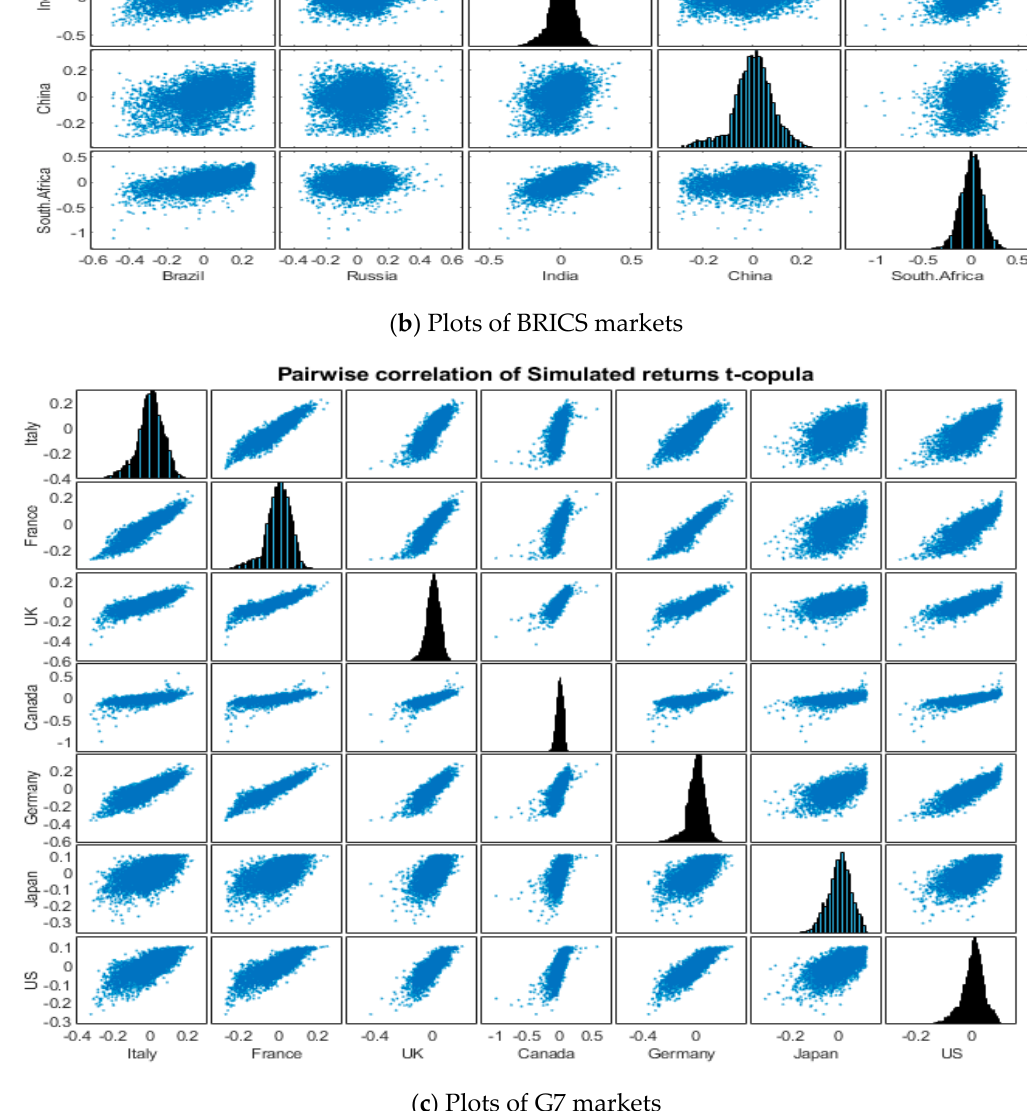
Figure 4. Pairwise correlation of simulated returns, t -copula.